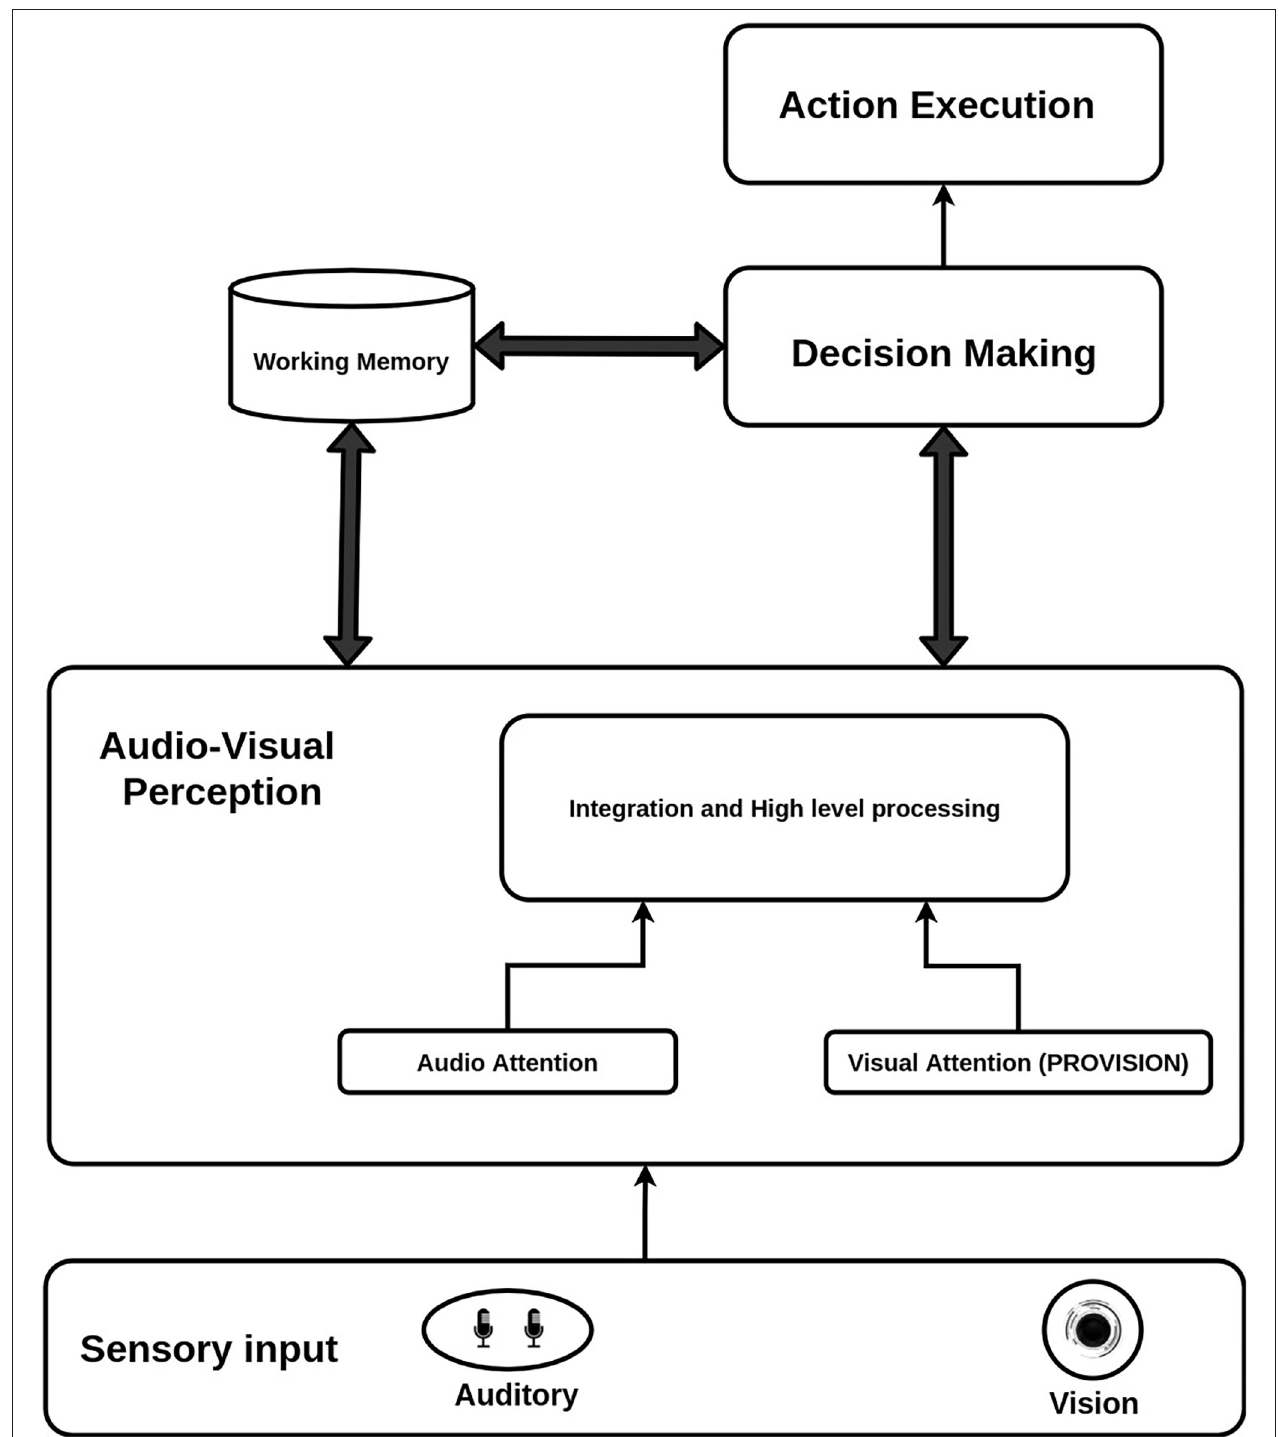
FIGURE 1 | Over all cognitive architecture with all the main layers.